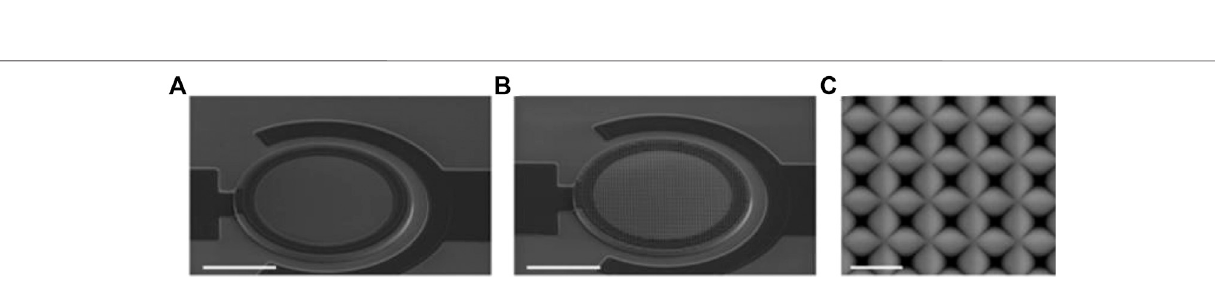
Frontiers in Physics |